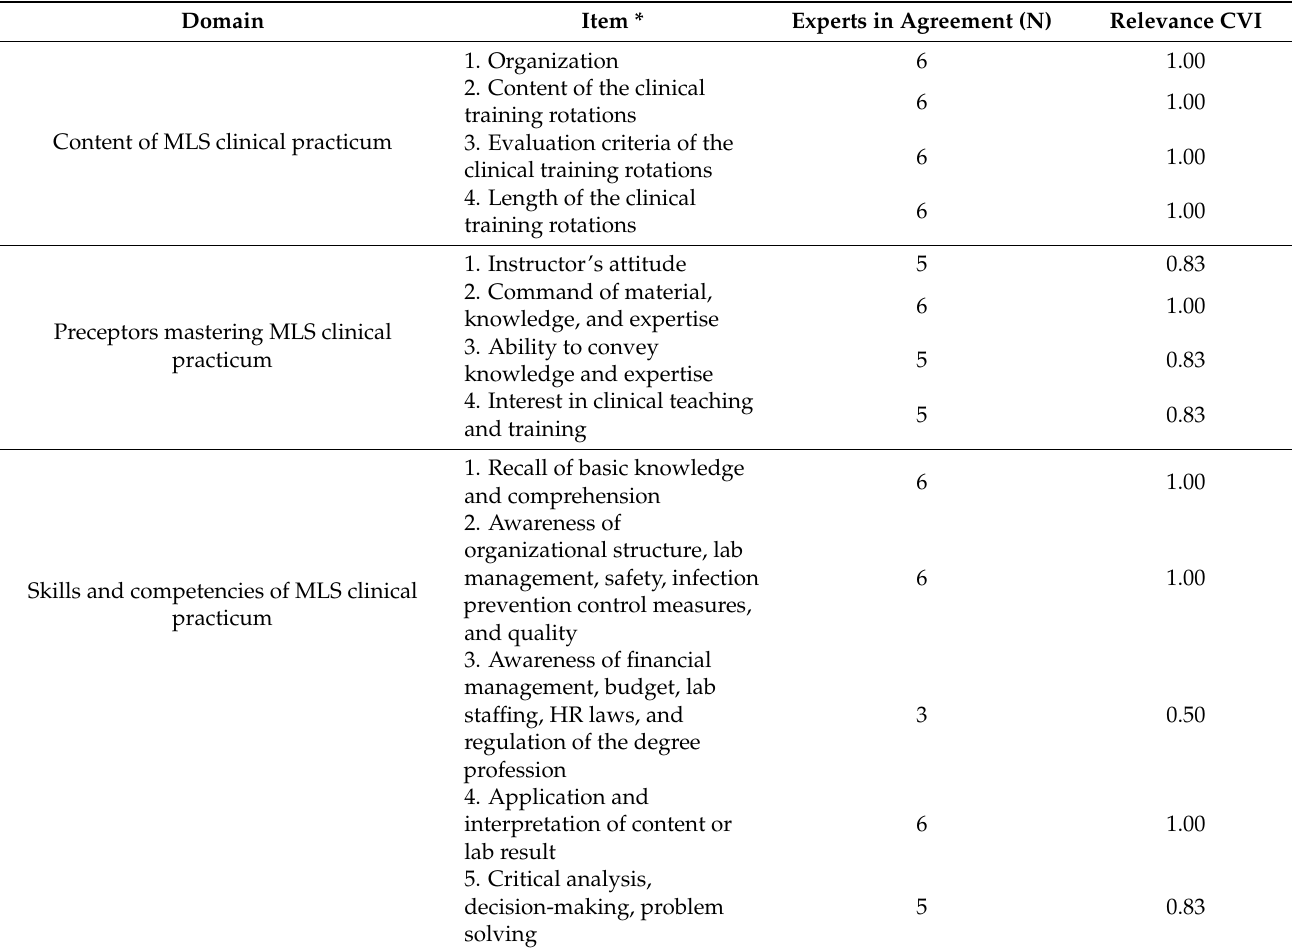
Table 1. CPAT-QU items with inadequate universal agreement among the